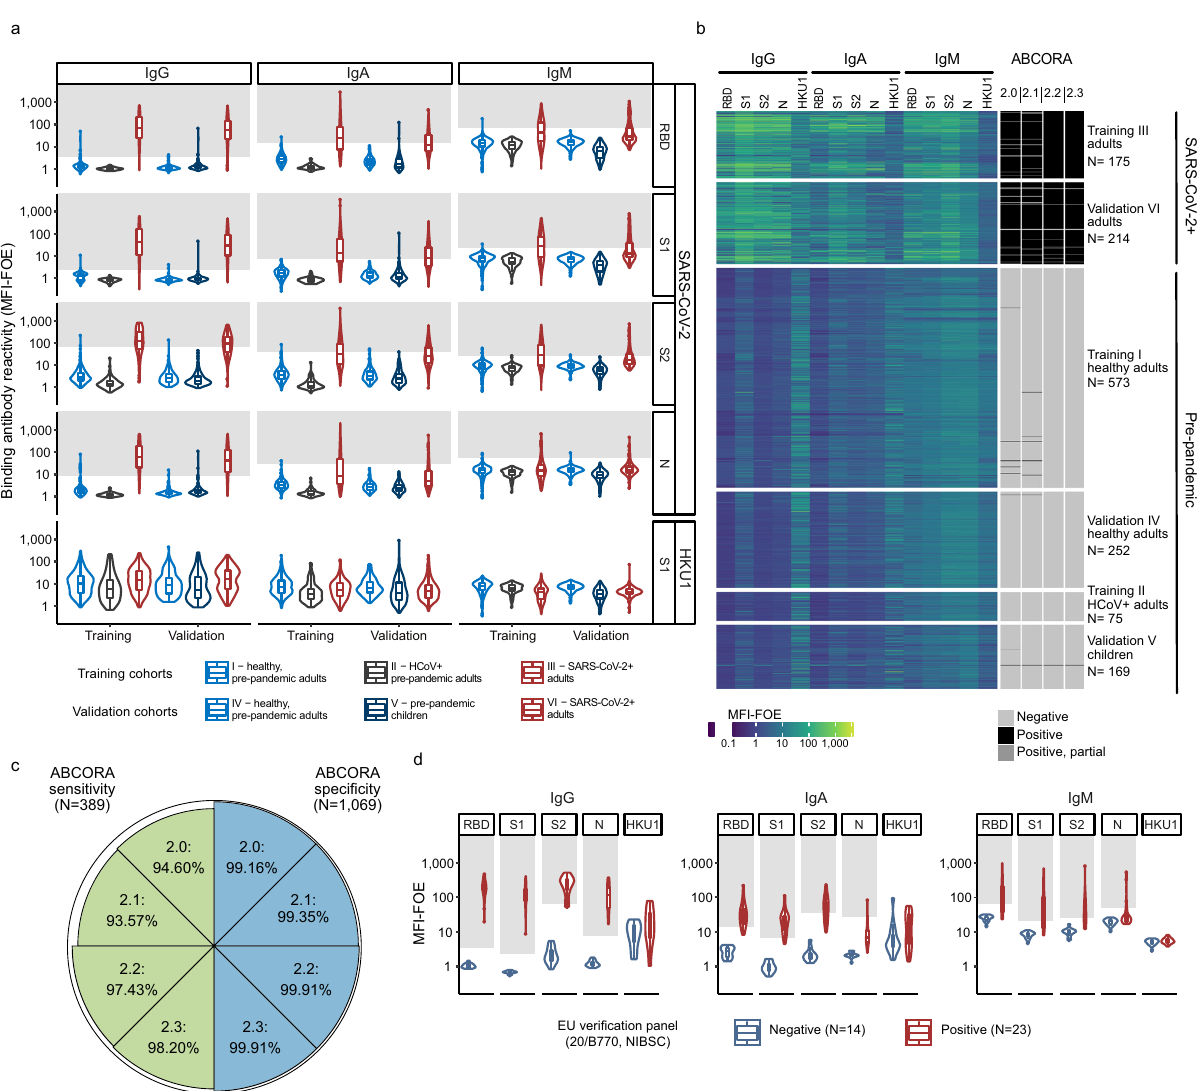
Fig. 1 Seropro fi ling SARS-CoV-2 responses. a Assessment of the multiplex SARS-CoV-2 ABCORA 2.0 on the indicated training ( N = 823) and validation ( N = 635) cohorts (Supplementary Table 3). Depicted are MFI signals normalized to empty bead controls (MFI-FOE). Gray boxes indicate values above the individually set MFI-FOE cut-offs for SARS-CoV-2 speci fi c responses for each antigen (see Supplementary Table 4). Boxplots represent the following: median with the middle line, upper and lower quartiles with the box limits, 1.5x interquartile ranges with the whiskers. b Heatmap representing the measured MFI-FOE values and the outcomes predicted with ABCORA 2.0 – 2.3 of training and validation cohort measurements shown in ( a ). Negative, Positive, and Positive, partial refer to ranking according to ABCORA 2.0 as speci fi ed in Supplementary Table 5. c Sensitivity and speci fi city of ABCORA 2 assay versions based on the combined training and validation cohort data depicted in ( a ). Proportion of false negative samples (sensitivity; green) and proportion of false positive samples (speci fi city; blue) are represented by the reduction from 100% (outer circle) per segment. d Assessment of ABCORA 2.0 with the National Institute for Biological Standards and Control (NIBSC) Anti SARS-CoV-2 Veri fi cation Panel (20/B770) comprising SARS-CoV-2 positive (red) and negative (blue) panel serum samples. Gray boxes indicate values above the ABCORA 2.0 MFI-FOE cut-offs for SARS-CoV-2 speci fi c responses for individual antigen-Ig combinations. Boxplots represent the following: median with the middle line, upper and lower quartiles with the box limits, 1.5x interquartile ranges with the